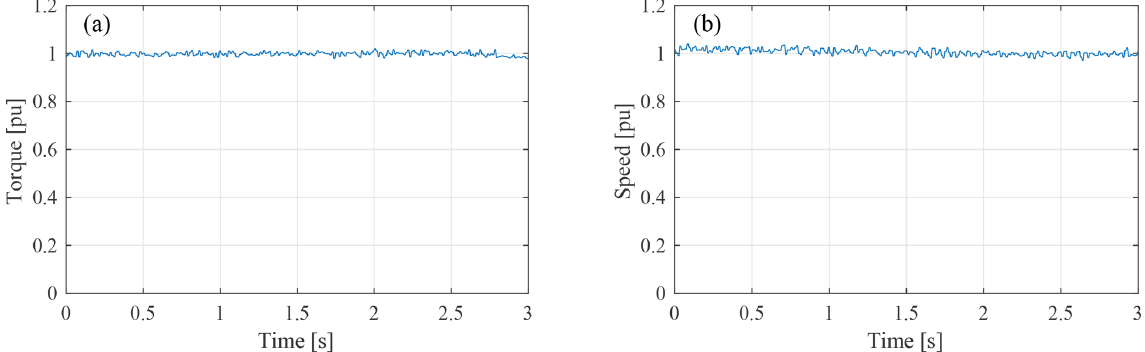
Figure 10. Wind turbine VSC under a voltage dip: generator torque (a) and speed (b)